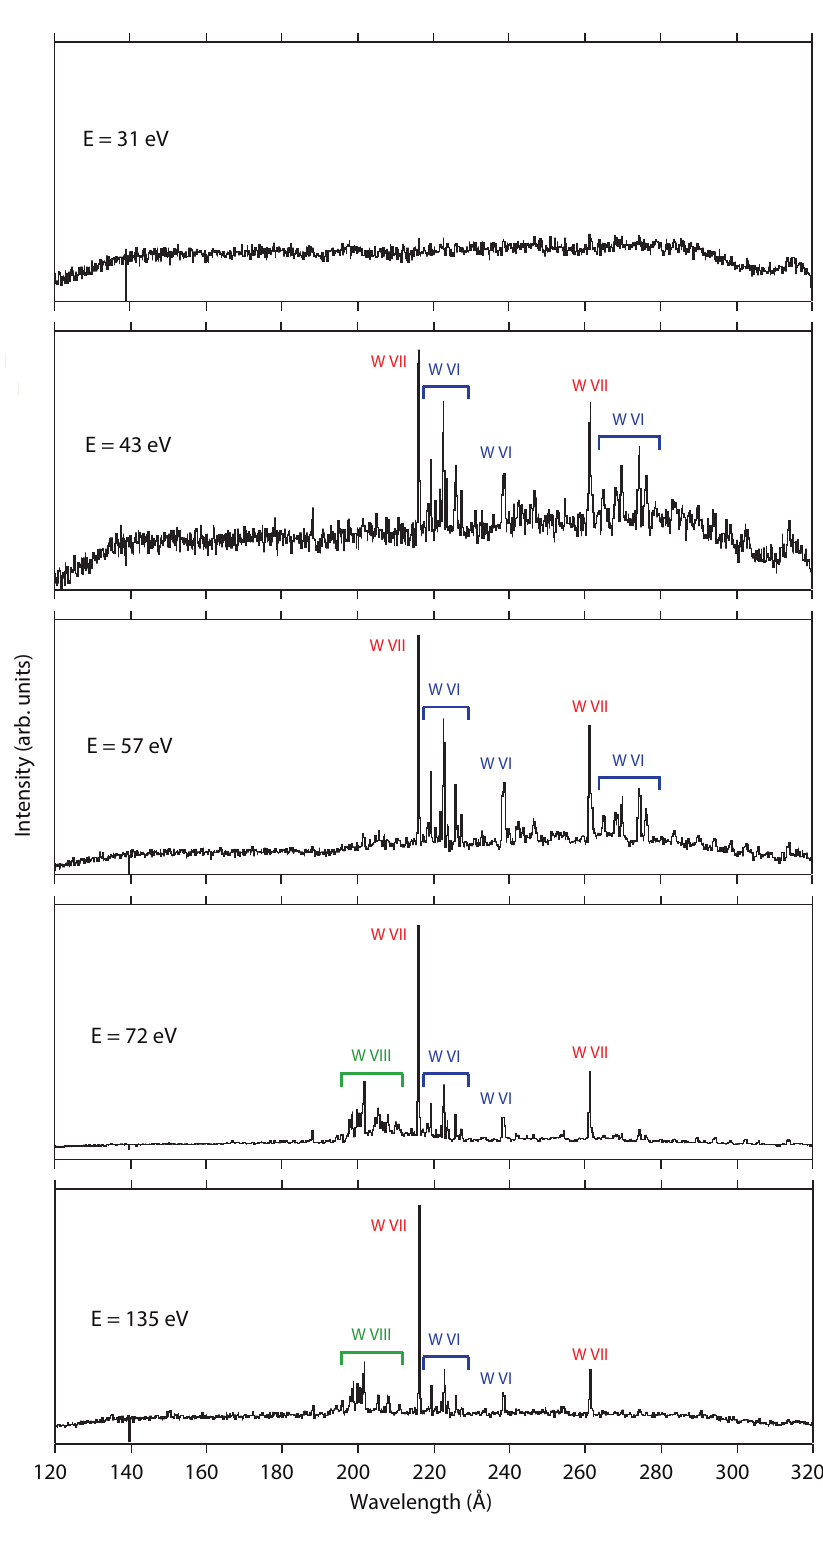
Figure 1. Tungsten spectra measured at EBIT-I at nominal electron-beam energies of E = 31–135 eV. Strong lines and intervals are labeled according to dominating